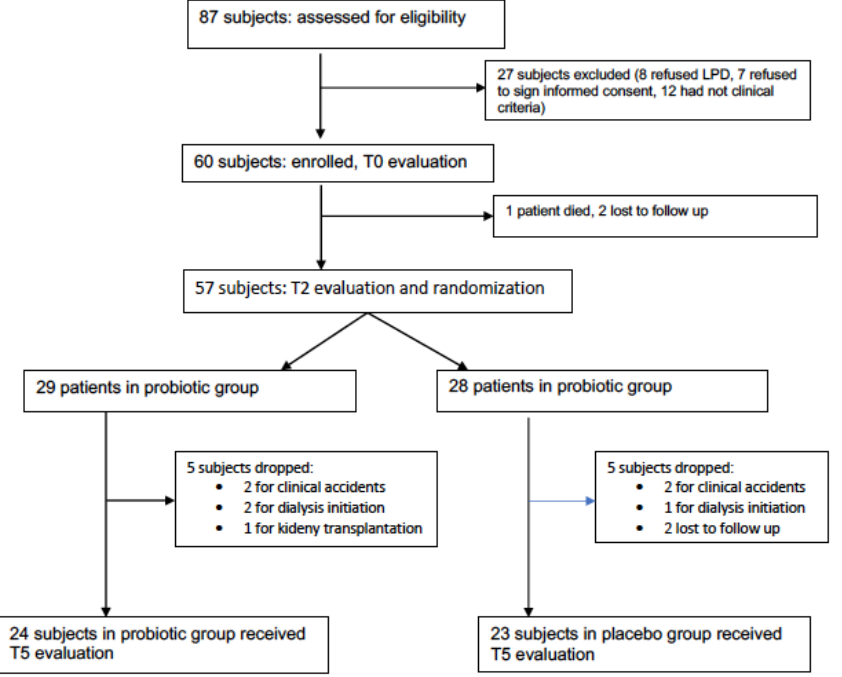
Figure 1. Flow chart of patient evaluations.